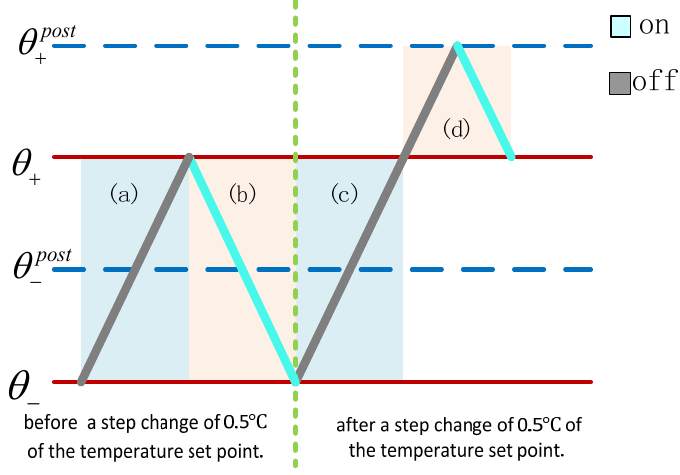
Figure 2. The temperature distribution of ACs before and after a step change of 0.5 °C of the temperature set